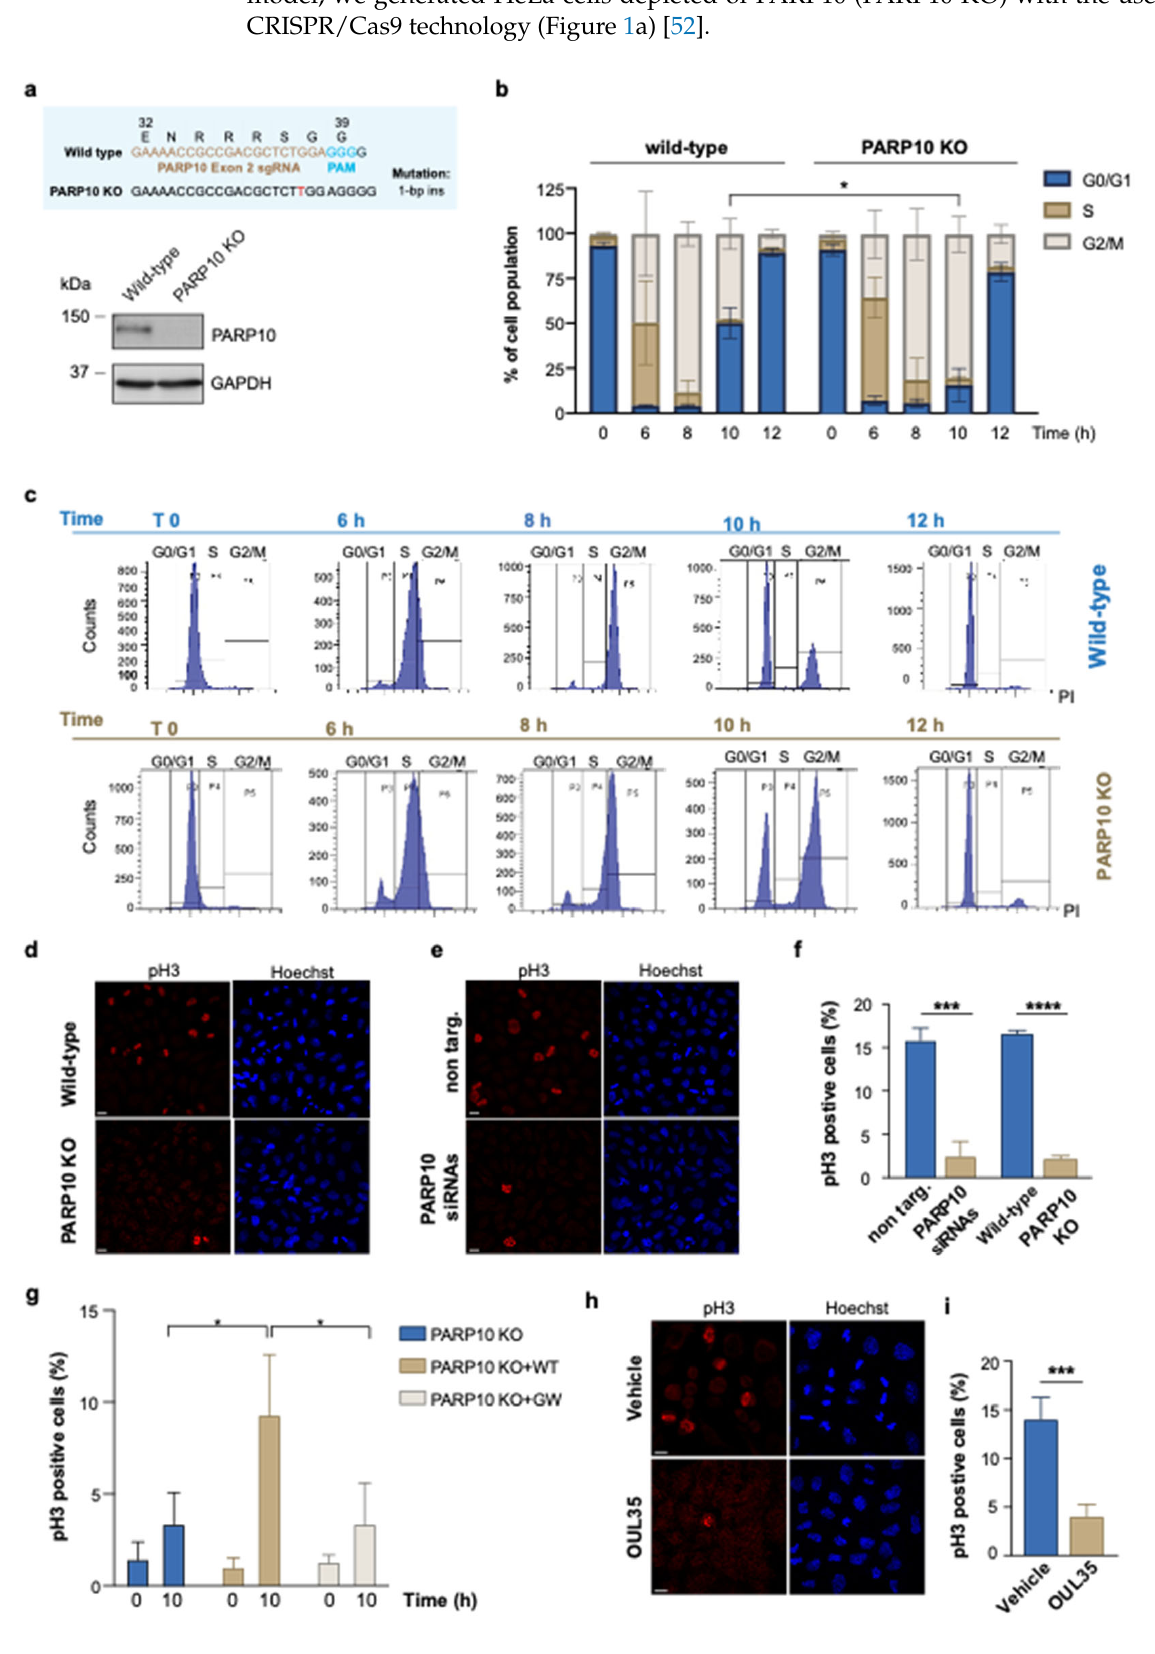
Figure 1. Depletion of PARP10 impairs the G2/M transition. ( a ) PARP10 KO HeLa cell line was gen ‐ erated by CRISPR/Cas9 approach. The resulting KO clone was validated by Sanger sequencing (up ‐ per panel) and Western blot analysis (lower panel). ( b , c ) Wild ‐ type and PARP10 KO HeLa cells were synchronized by using double thymidine blocks, harvested at the indicated time points, and ana ‐ lyzed by flow cytometry using propidium iodide staining. Quantification data are means (±S.D.)